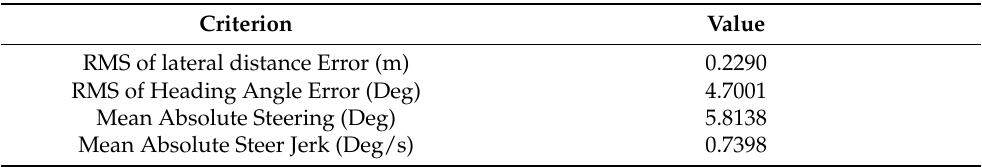
Table 2. Controller